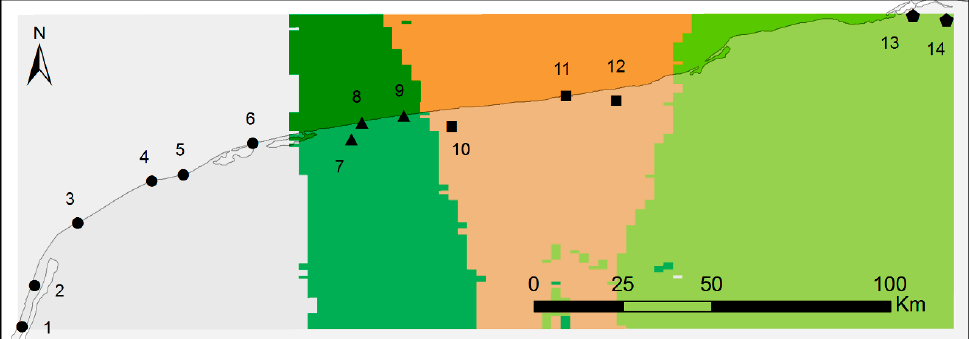
lowest F ST average values (orange area with squares in Figure 4) were found in populations in Xcambó, Santa Clara, and Dzilam (average F ST = 0.10). The last identifiable group comprised the largest number of sites located in the west of Progreso city (grey area with circles in Figure 4; average F ST = 0.11). Progreso city is located between the sampling sites Chuburná and Capilla.